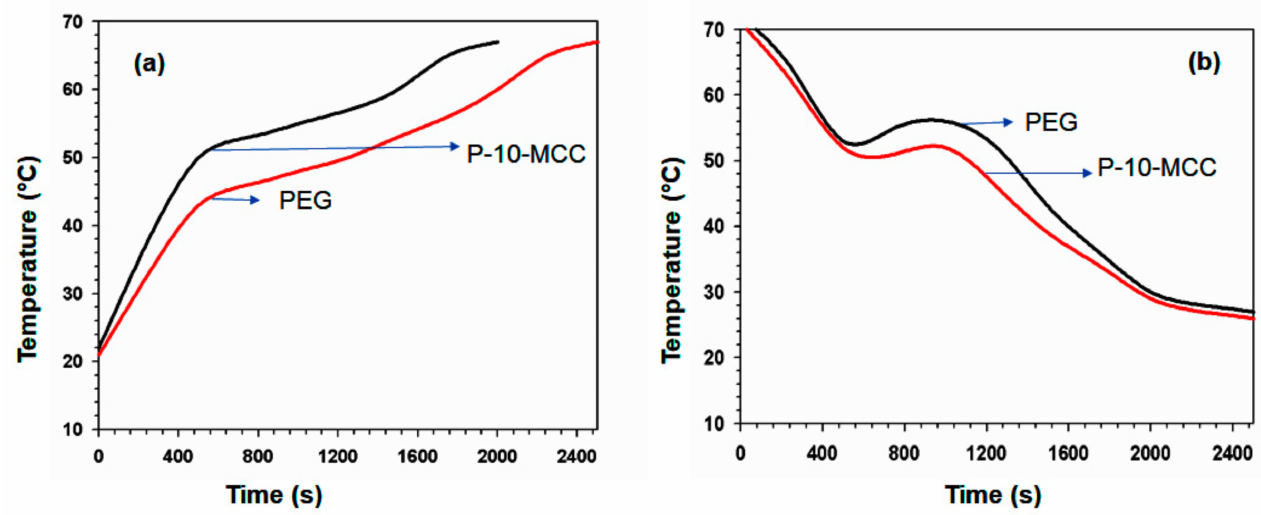
Figure 15. ( a ) Heating temperature curves of PEG 6000 and P-10-MCC composite; ( b ) freezing temperature curves for the